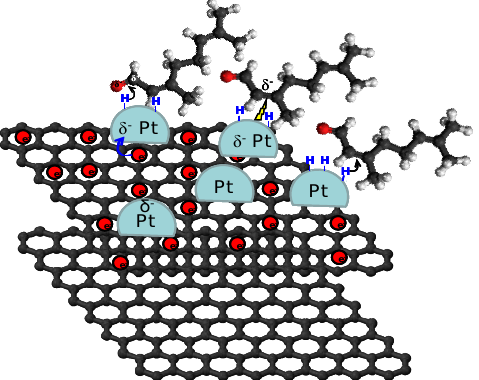
Figure 5. Electron transfer from the graphitic support to the metal